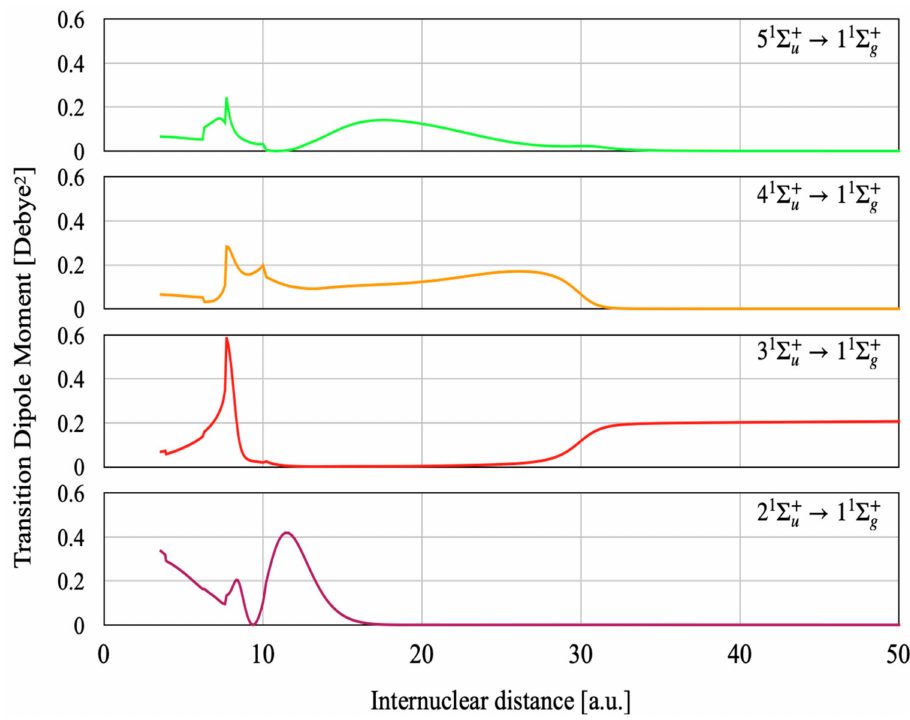
Figure 2. Transitional dipole moment (Squared) from the ground state to the 1 Σ g+